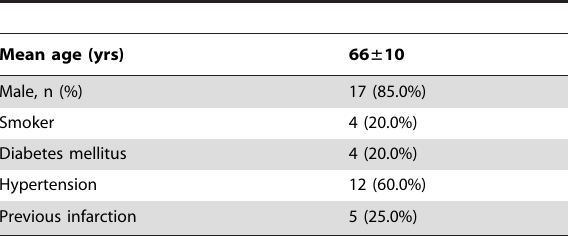
Table 1. Clinical characteristics of the study population ( n =20).